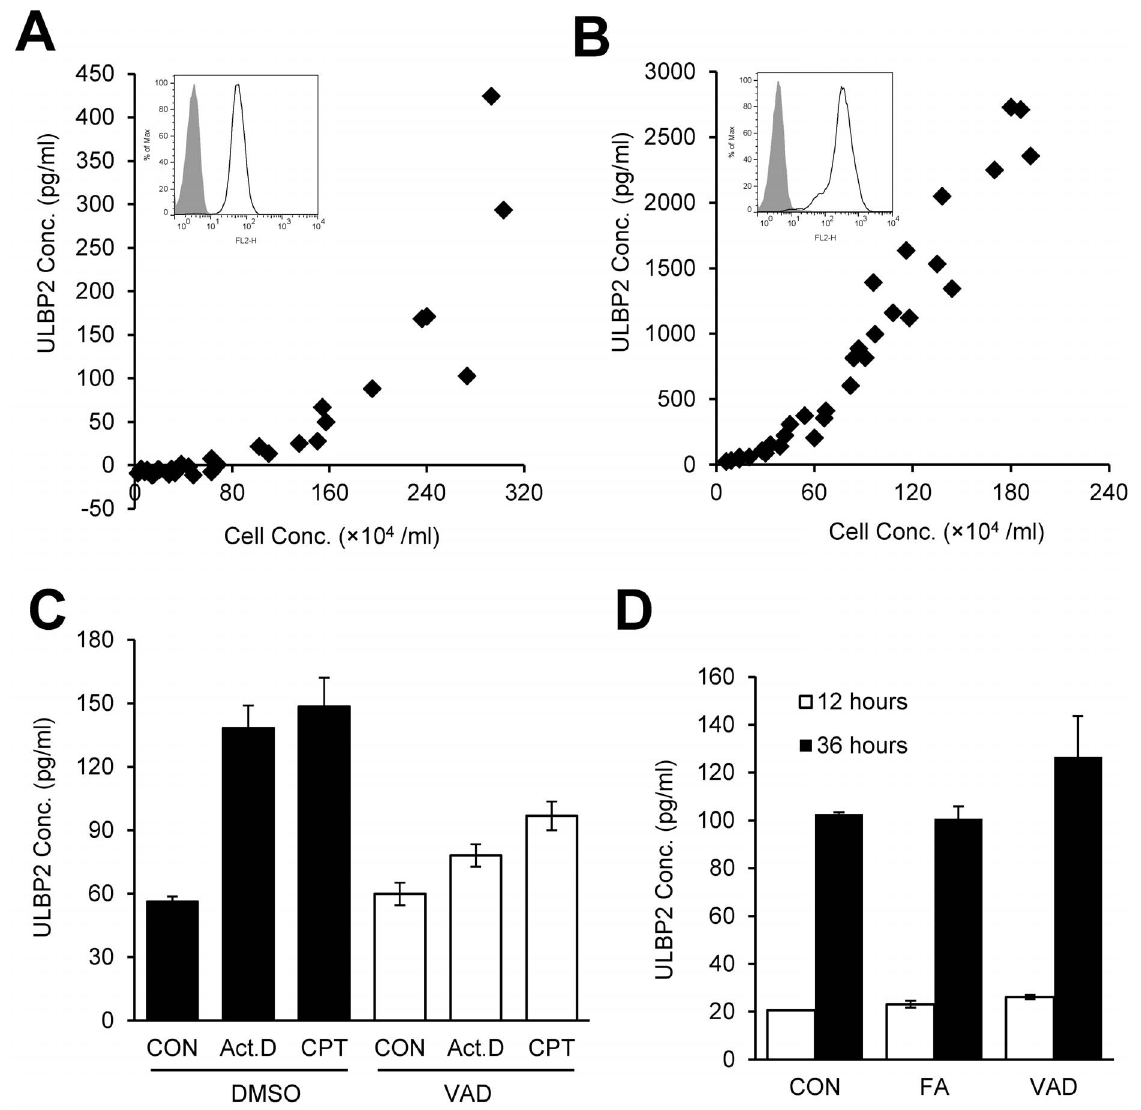
Figure 5. Spontaneous shedding of ULBP2 does not result from tumor cell apoptosis. (A, B) Spontaneous shedding of ULBP2 from Jurkat and H9 cells. Jurkat (A) or H9 (B) cells were cultured with initial seeding cell numbers ranging from 0.5 6 10 5 to 4 6 10 5 cells/ml in 48-well plates, the cells were harvested at various time points (from 17 to 98 hours) to achieve various cell densities, and their released ULBP2 in supernatants were determined by ELISA. The expression of ULBP2 was also been determined by FACS using PE-conjugated anti-human ULBP2 antibody. Cell surface expression of ULBP2 in Jurkat and H9 cells are shown in solid lines, and isotype controls are shown in gray-shaded histograms. (C) Shedding of ULBP2 from apoptotic cells. 4 6 10 6 Jurkat cells were pre-treated with DMSO or 50 m M Z-VAD-FMK for 30 min, and then treated with ActD and CPT for 6 hours in serum free medium. The resulting culture supernatants were collected for ULBP2 ELISA. (D) Z-VAD-FMK fails to block spontaneous shedding of ULBP2. 8 6 10 4 Jurkat cells were cultured in RPMI 1640 medium with 10% FBS in the presence of 50 m M Z-FA-FMK, Z-VAD-FMK or their carrier control DMSO for the indicated time. The culture supernatants were used to determine ULBP2 concentration. doi:10.1371/journal.pone.0091133.g005 ULBP2 was shed from target cells in response to NK cell-mediated (Fig. 4C) and H9 cells (Fig. 4D) into cell culture supernatants. Since ELISA does not distinguish soluble proteins released by shedding from those presented in exosomes, we further used flow cytometry to investigate if soluble ULBP2 is associated with exosomal pathway. As shown in Fig. 4E, latex beads coated with exosomes prepared from ActD or CPT treated H9 cells were positive of exosome marker CD63 [18]. These exosome-coated beads, however, failed to be stained by the ULBP2 antibody. Thus, ULBP2 released from apoptotic cells was not associated with exosome exocytosis. Together, these results showed that